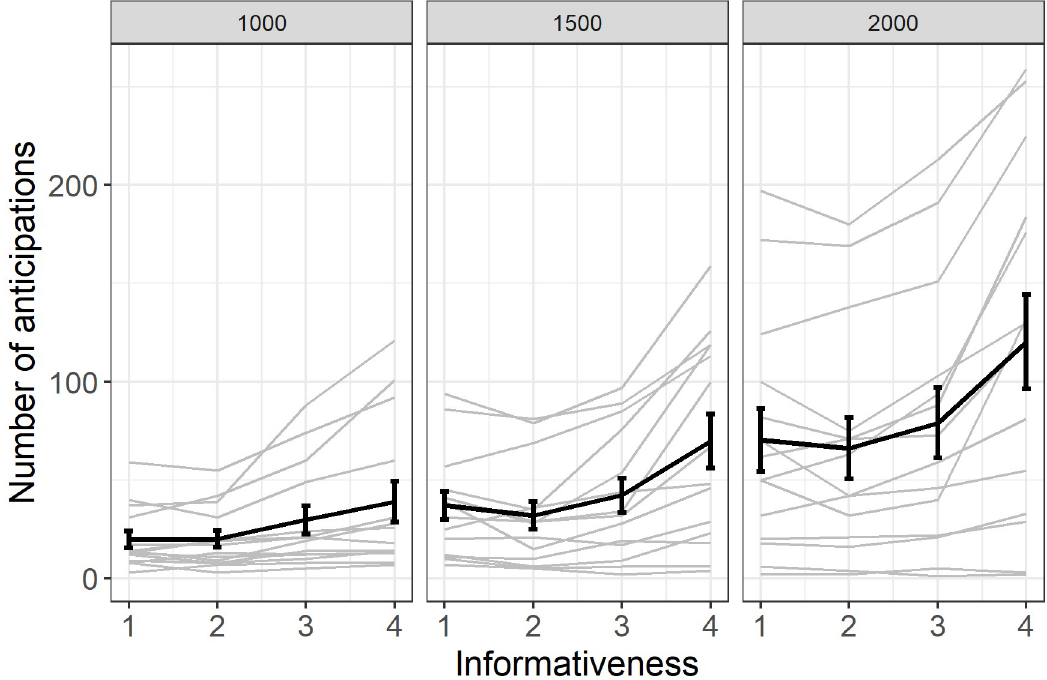
Fig 2. The number of anticipations increases with informativeness. Individual responses (light grey) with group average (error bars represent standard error).